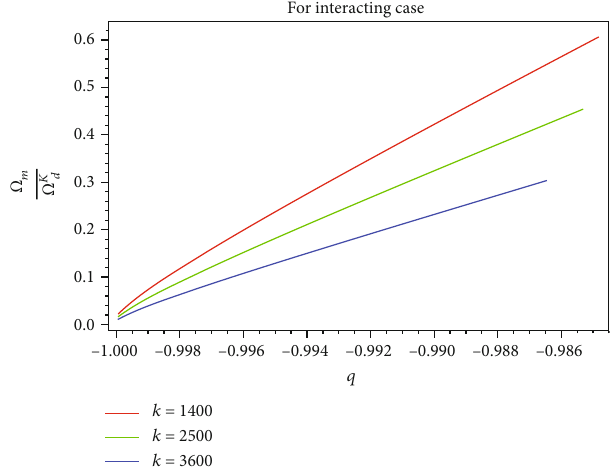
/ Ω K against m d